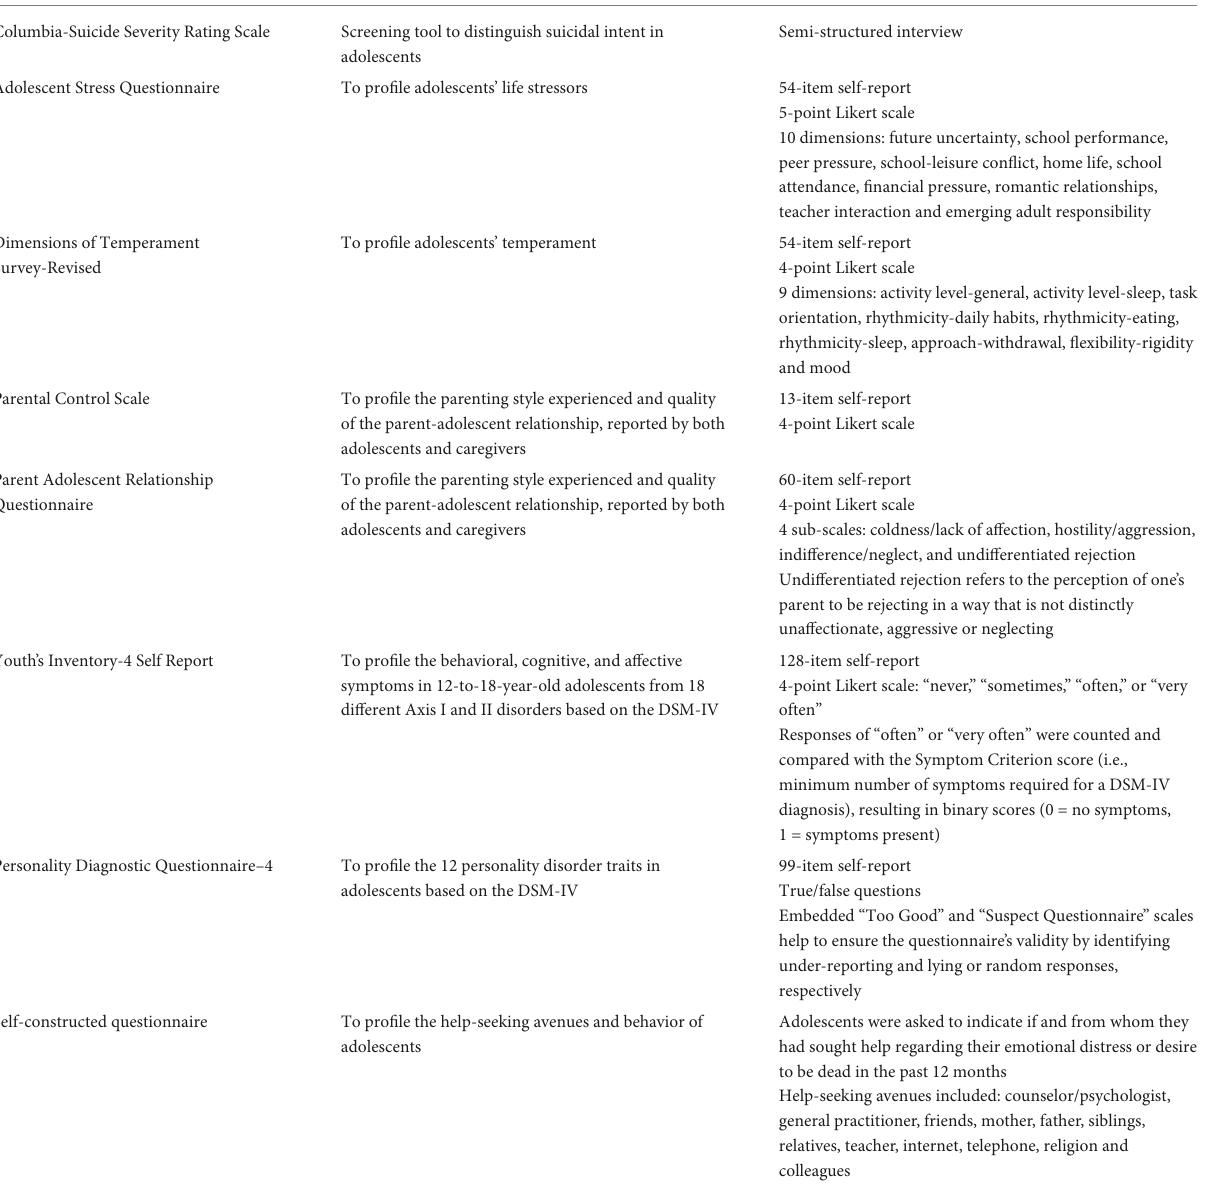
TABLE 2 Details of measurement